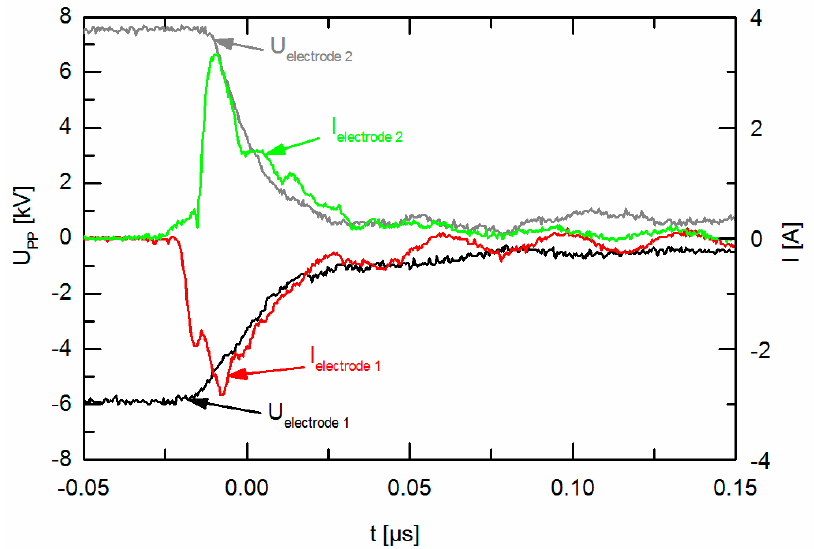
Figure 3. Electrical characterization of one discharge event with tap water as liquid [30]: Driving voltage at the electrodes (black and grey lines) and discharge current (red and green lines), discharges take place at both electrodes simultaneously.